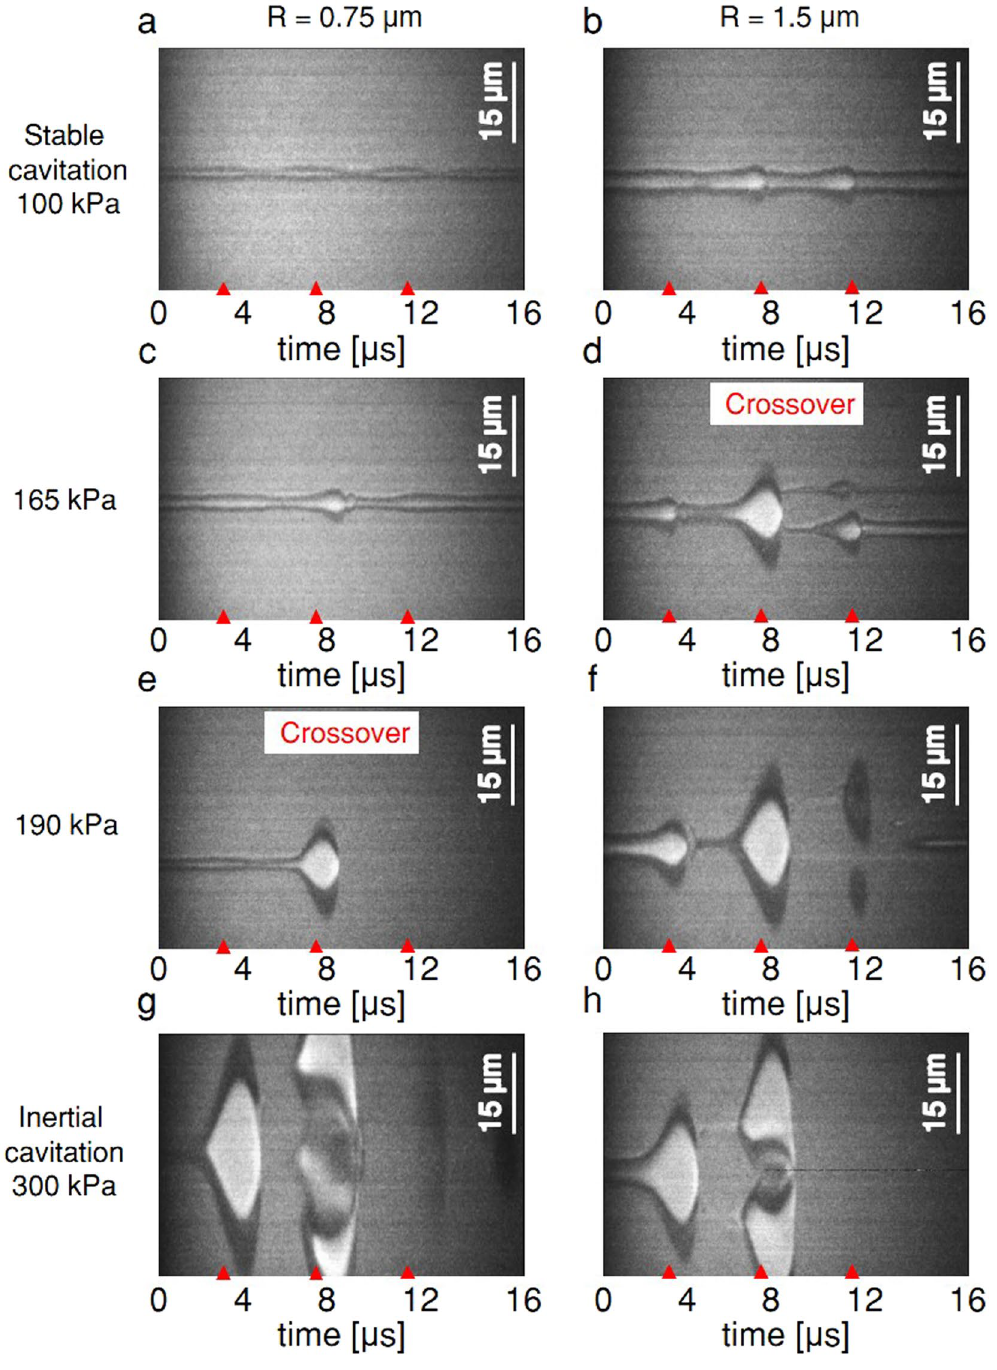
Figure 3. Ultra high-speed camera streak images of oscillating MBs for a transmission center frequency of 250 kHz with radii of 0.75 μ m and 1.5 μ m at various peak negative pressure (PNP). ( a , b ) 100 kPa. ( c , d ) 165 kPa. ( e , f ) 190 kPa. ( g , h ) 300